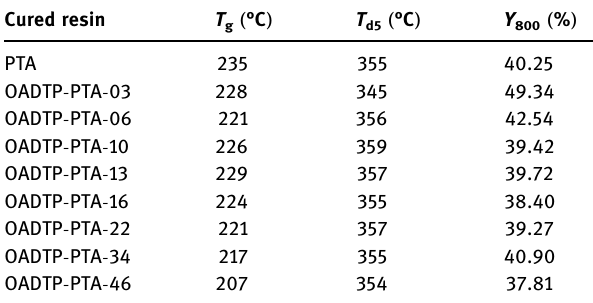
Table 4: Thermal properties of cured PTA and OADTP - PTA resins Cured